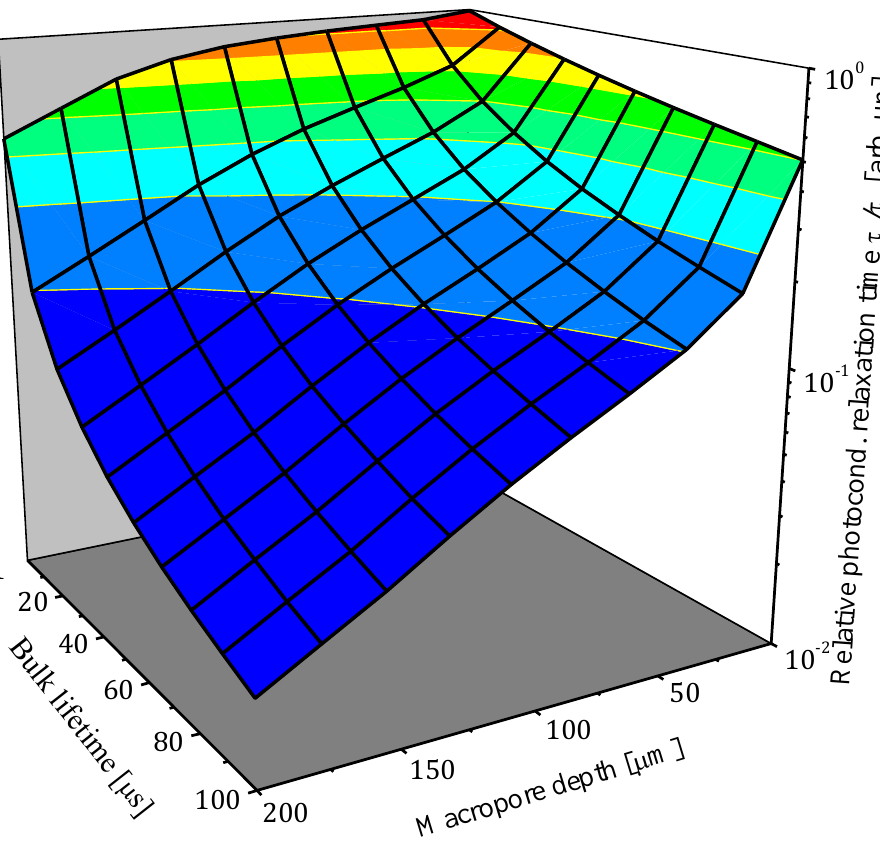
Figure 6. The dependence of the relative relaxation time of photoconductivity on the depth of the macropores and the bulk lifetime at thickness of macroporous silicon is 200